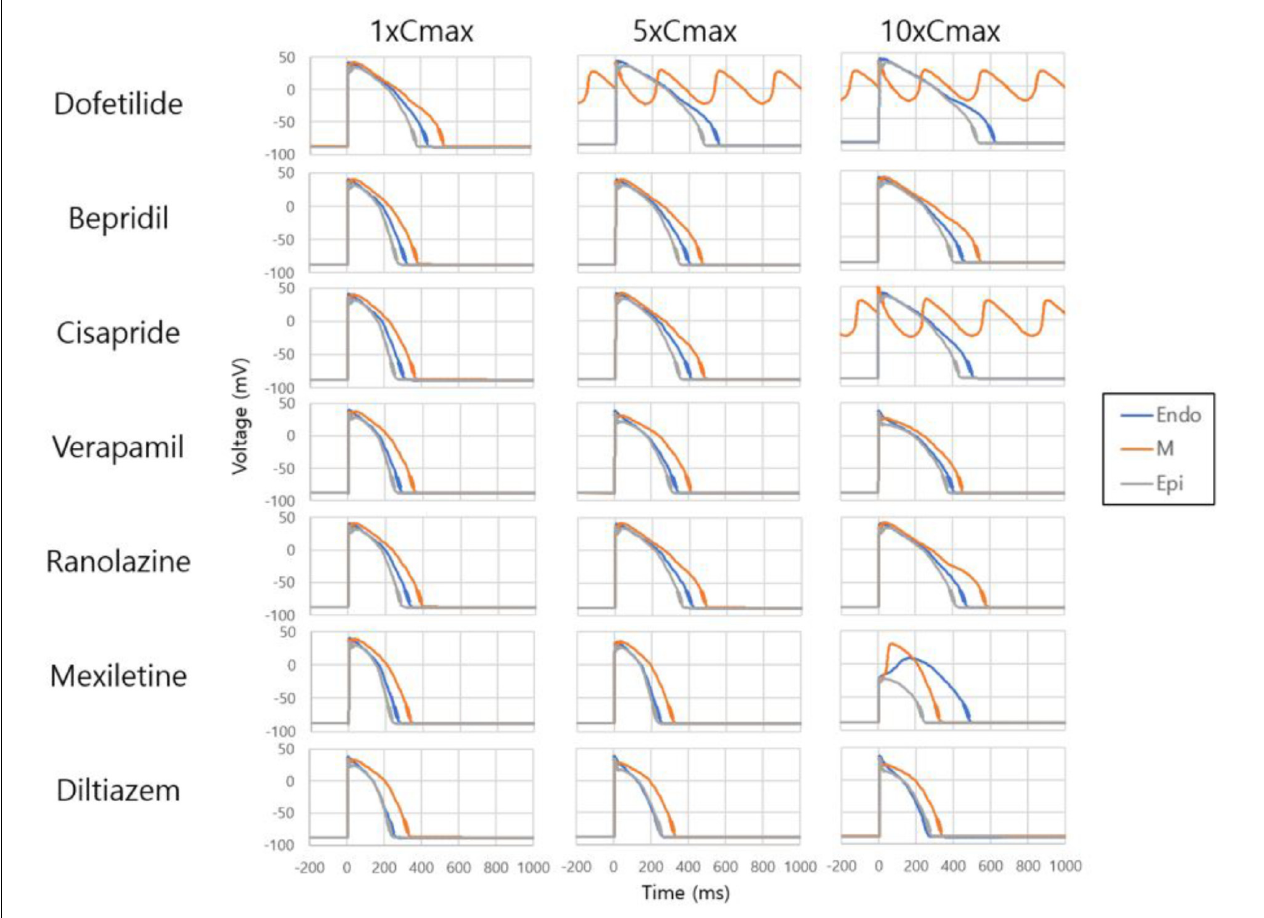
FIGURE 2 | Effects on single-cell action potential. Action potential curves are shown for 7 drugs at Cmax values of 1 × , 5 × , and 10 × . The action potentials of endocardial, M, and epicardial cells are shown for each drug and Cmax value. Dofetilide at Cmax values of 5 × and 10 × and cisapride at 10 × induced tachycardia.